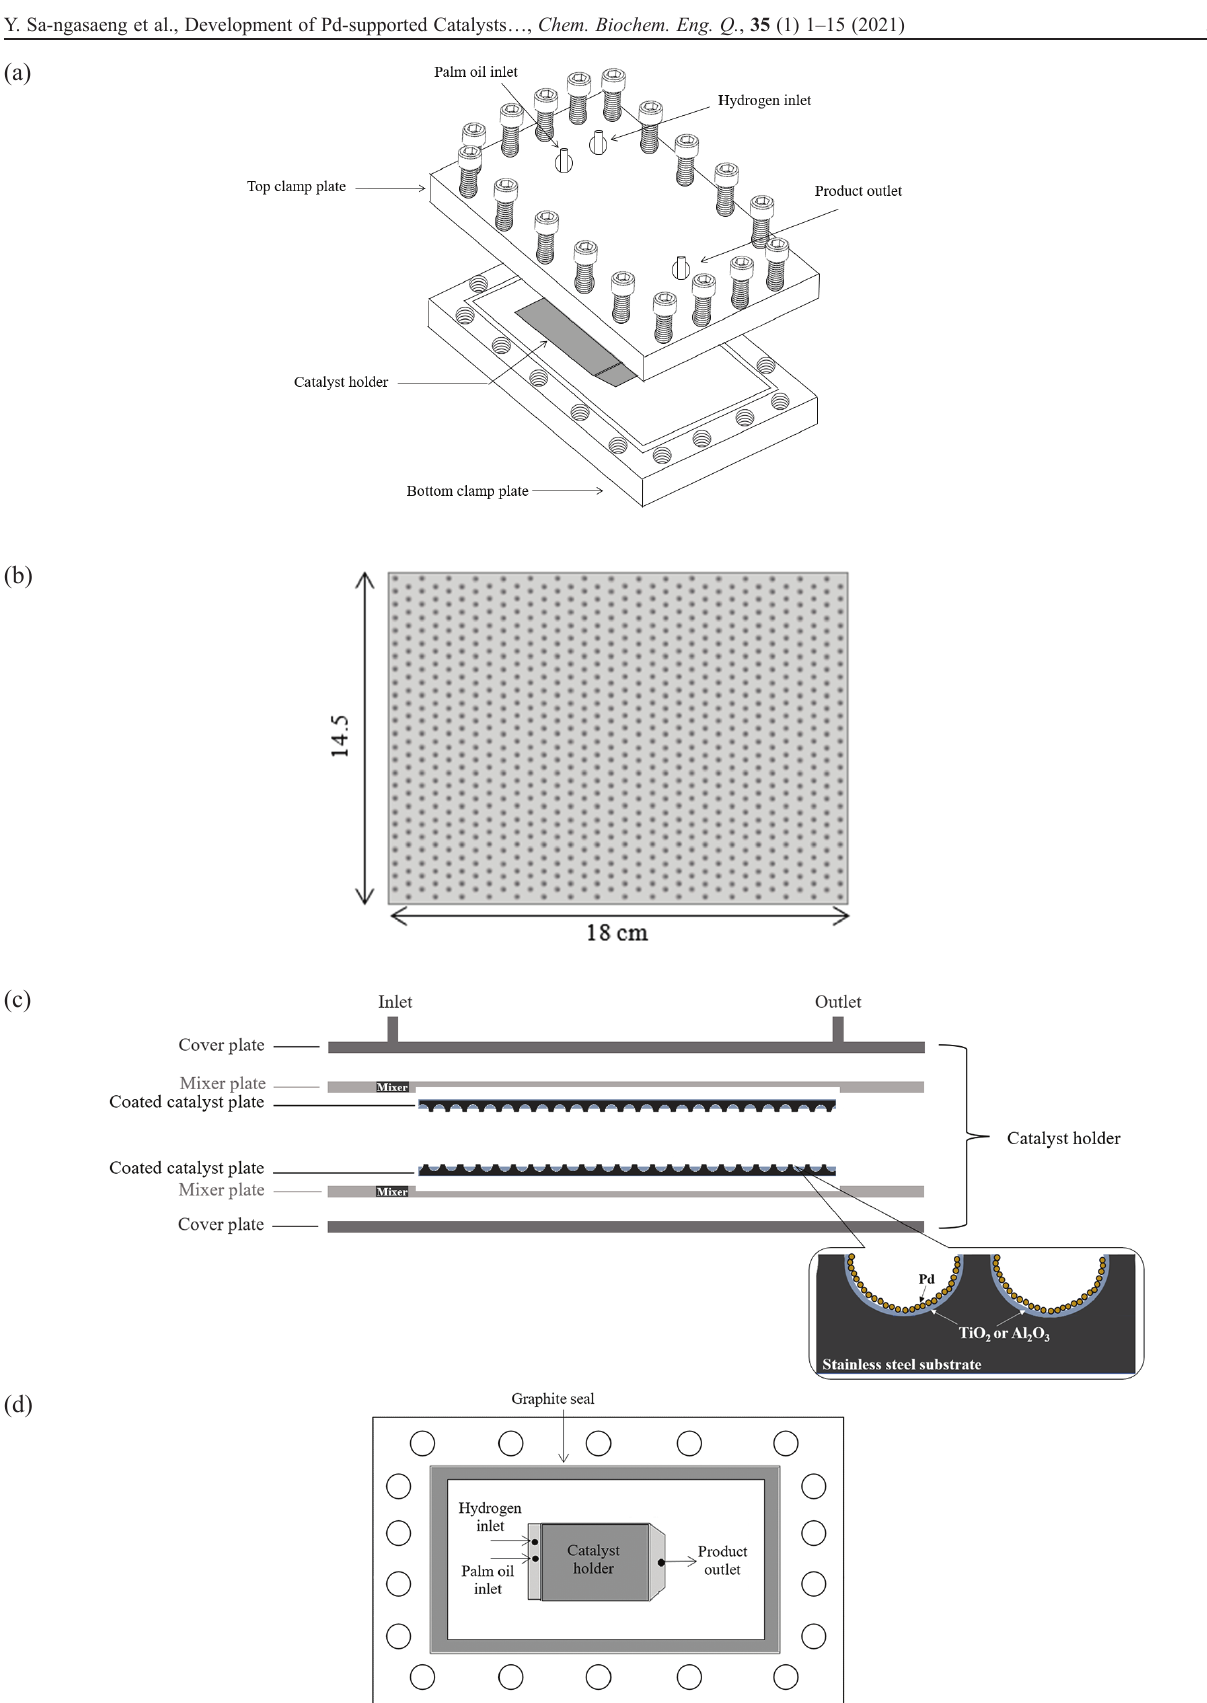
Fig. 1 – Schematic of microscale-based reactor design: (a) three-dimensional view, (b) top view of catalyst plate, (c) cross-section view of catalyst holder with the coated catalyst on the substrate plate, and (d) top view of bottom clamp